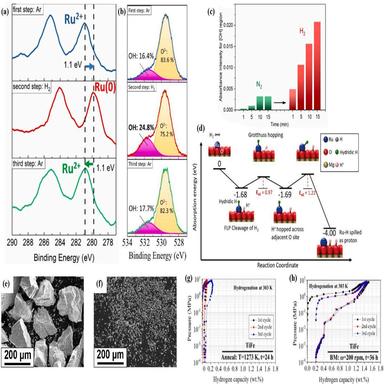
XPS spectra of (a) Ru 3d and (b) O 1s for Ru-doped MgO (111) nanosheet under ambient pressure between treatments of 1 mbar Ar and 1 mbar H2 at 350 ◦C, (c) relative absorbance intensity of the difference spectra of in-situ DRIFT at 3300 cm− 1 , and (d) mechanism of how hydrogen travels on the surface. (e, f) SEM images of TiFe powder (e) before and (f) after ball mill for 36 h. (g, h) PCT curves at 303 K for TiFe power (g) before and (h) after ball mill for 36 h. (a–d) Reproduced with permission from .](#pag